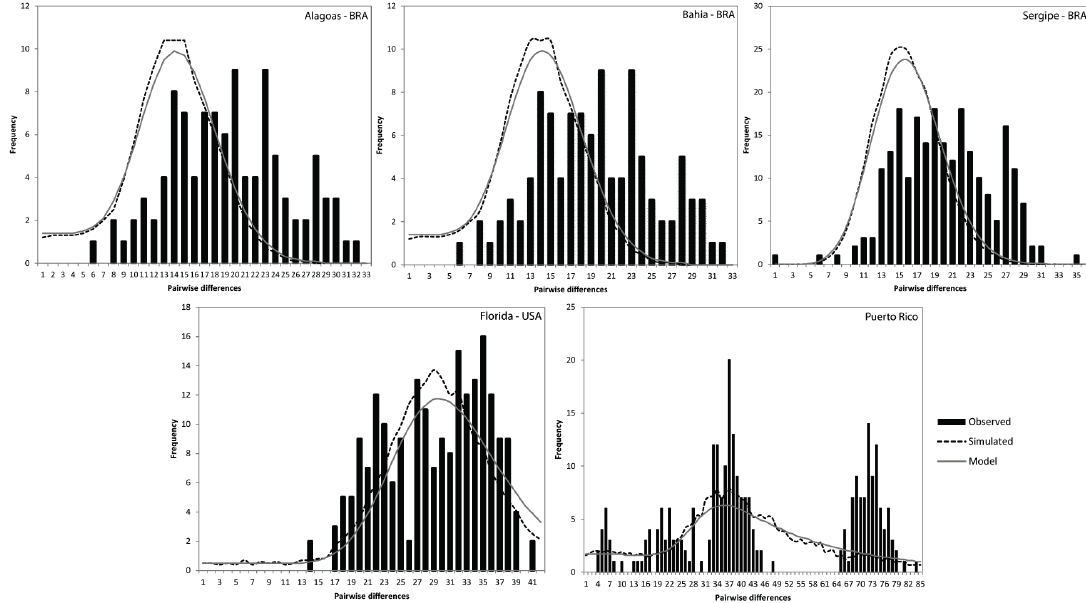
Figure 6. Frequency distributions of the number of pairwise nucleotide differences (mismatch) between C. guanhumi haplotypes for all